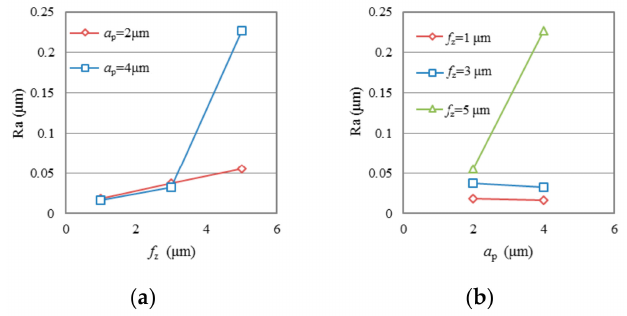
Figure 5. Surface roughness Ra as a function of ( a ) f z and ( b ) a p in test group TC.